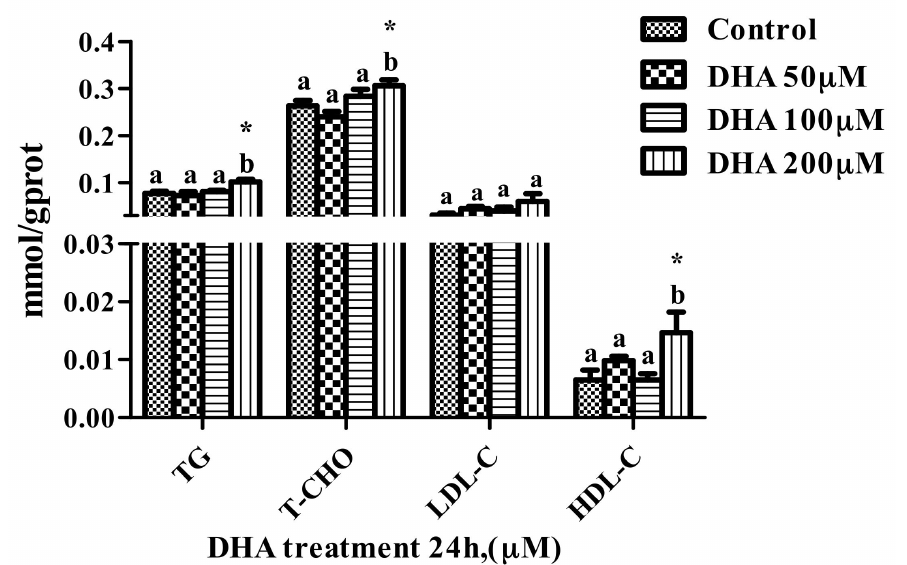
Figure 2. The effect of different concentrations of DHA-treated BRL-3A for 24 h on the lipid profile ( n = 3). Values are means with SEM, the SEM was presented with vertical bars; means with different letters are significantly different from one another ( p < 0.05) as determined by variance analysis followed by multiple comparisons with LSD post-hoc test; * statistically significant differences vs. control ( p <